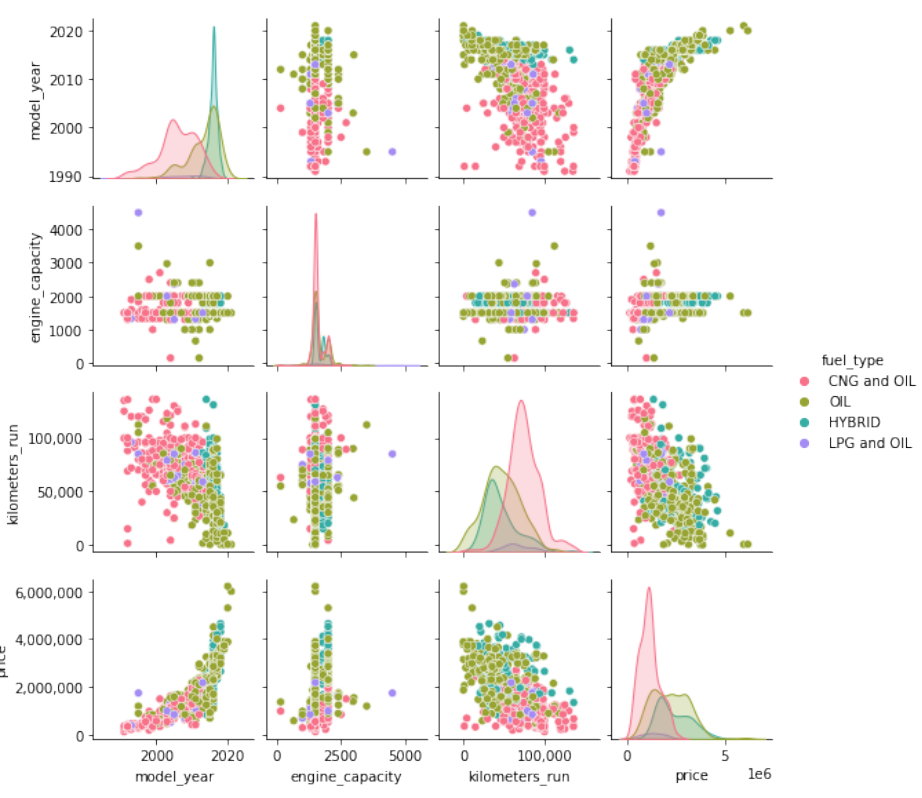
Figure 13. Pair plot of automatic cars with different fuel_type features.